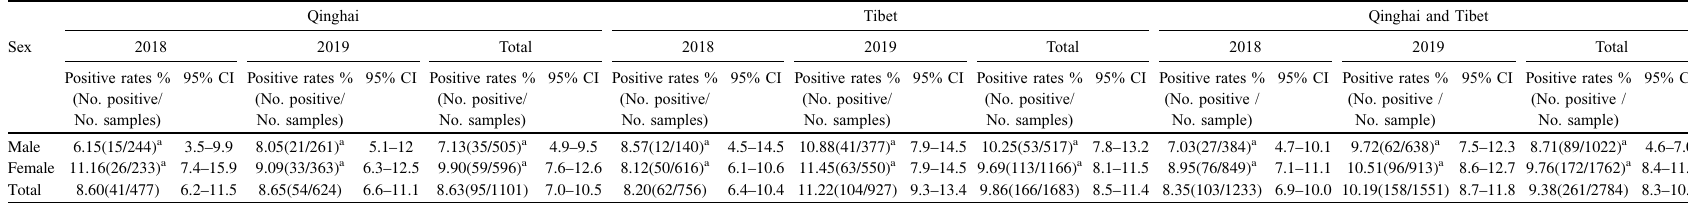
Note: The same lowercase letters within columns represent no signi fi cant differences between groups ( p > 0.05) and different lowercase letters within columns represent signi fi cant differences between groups ( p < 0.05).